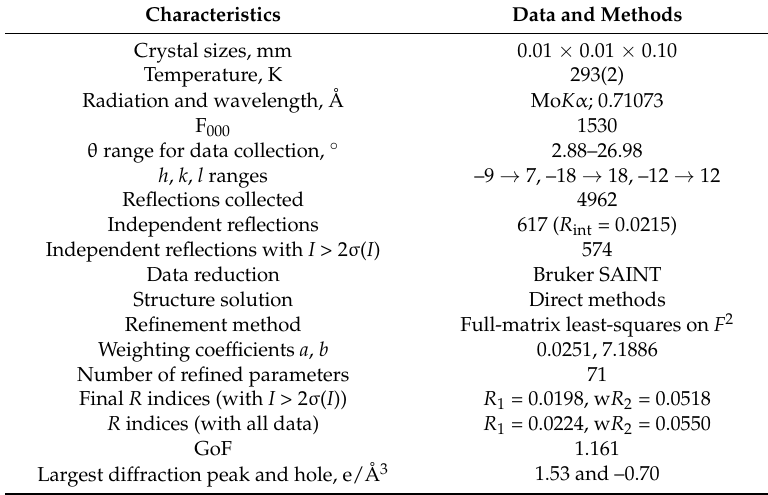
Table 1. Crystal data, data collection information and structure refinement details for the holotype specimen of